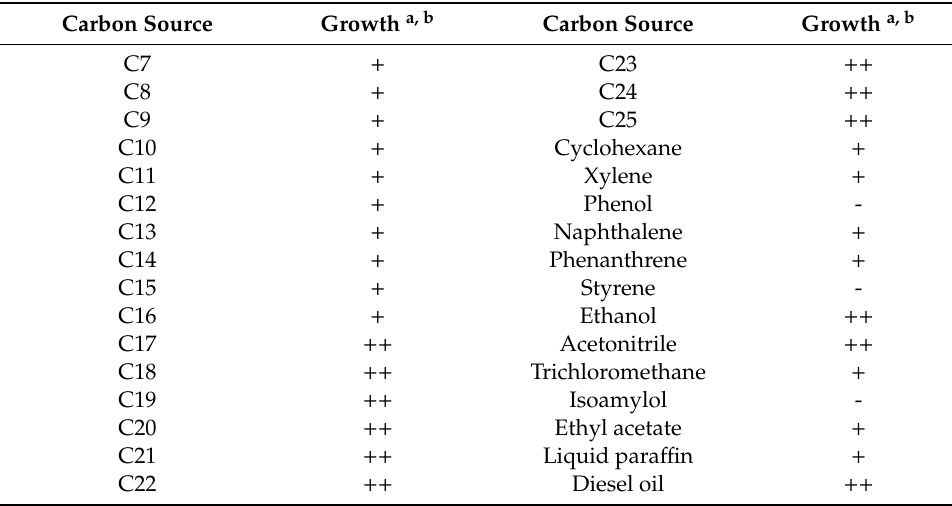
Table 1. Range of carbon sources utilized by strain BL-27 in MSM medium.